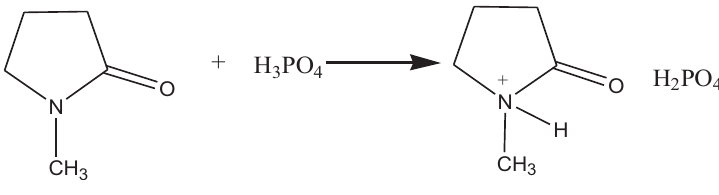
Fig. 1 – Synthesis route of [Hnmp]H